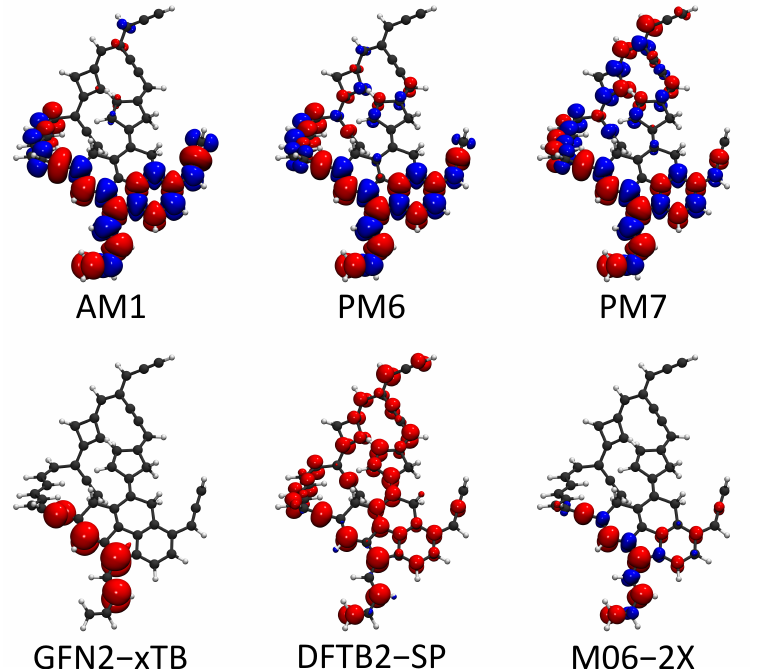
Figure 5. Spin density isosurfaces for the C 50 H 35 . The red color denotes the excess spin-up electron density ρ ↑ ( r ) and blue denotes the excess of the spin-down electron density ρ ↓ ( r ) . Moreover, the isosurface value is set at 0.003 e / ˚A 3 for both spin-up and spin-down